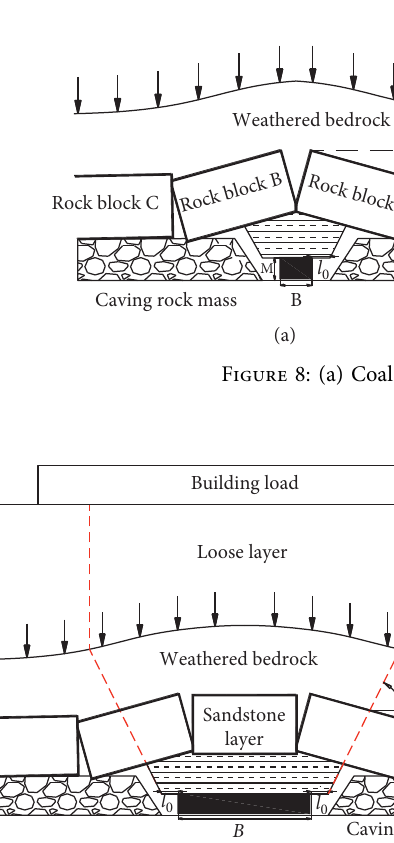
Figure 9: Schematic diagram of the load above the coal